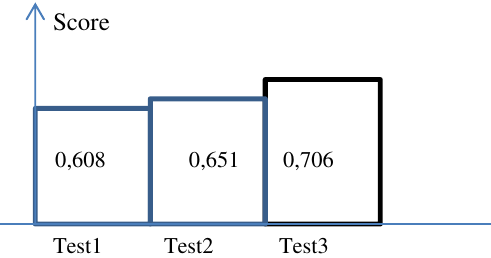
Fig. 7. Scores obtained in Test 1 (2012, without the use of e- learning tools), Test 2 (2013, repeated in 2015, with a gamified quizzing tool) and Test 3 (2015, with a gamified quizzing tool and a tool for the investigation of the deductive structures of